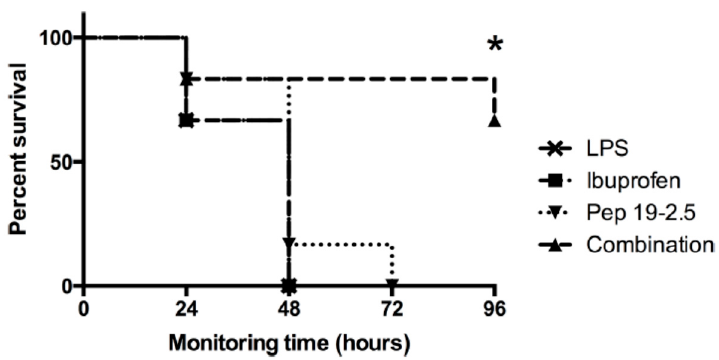
Figure 10. Pep19-2.5 and ibuprofen act synergistically against a lethal dose of LPS in a mouse model of endotoxemia. Redrawn from [13].